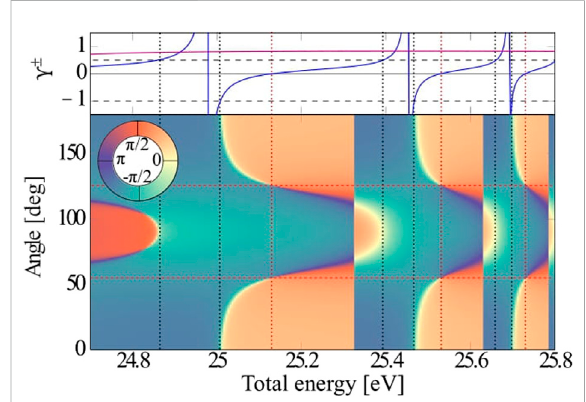
FIGURE 5 Phase variation of the absorption path as a function of angle and energy. The top fi gure shows the variation of ϒ ± with energy together with the limits of the inequality in Eq. 22 (dashed horizontal black lines). The absorption path is shown in blue and the emission path, which does not lead to any phase jump, in magenta. The black vertical dotted lines indicate the energies at which ϒ + intersects the black dashed lines. This indicates thelimits of the spectral region displaying phase jumps in angle. The vertical red dotted lines indicate the energies at which ϒ + changes sign, leading to a change in the direction of the phase jump in angle. At these energies, the phase jump occurs at the magic angle. The cycliccolorbarisshowninthetopleftcornerofthebottom fi